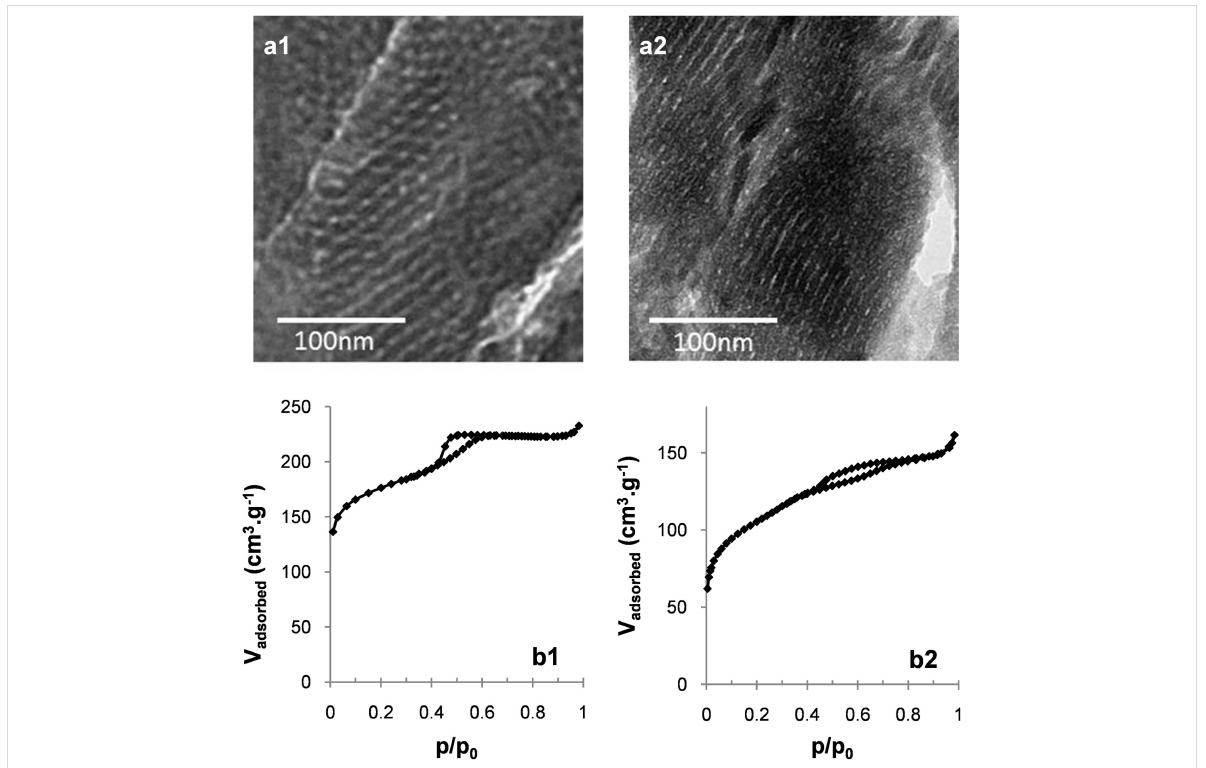
Figure 4: TEM micrographs (a) and N 2 adsorption/desorption isotherms (b) of the calcined materials prepared at 1.9 wt % DHBC at pH 4.5 (b1) and 6.5